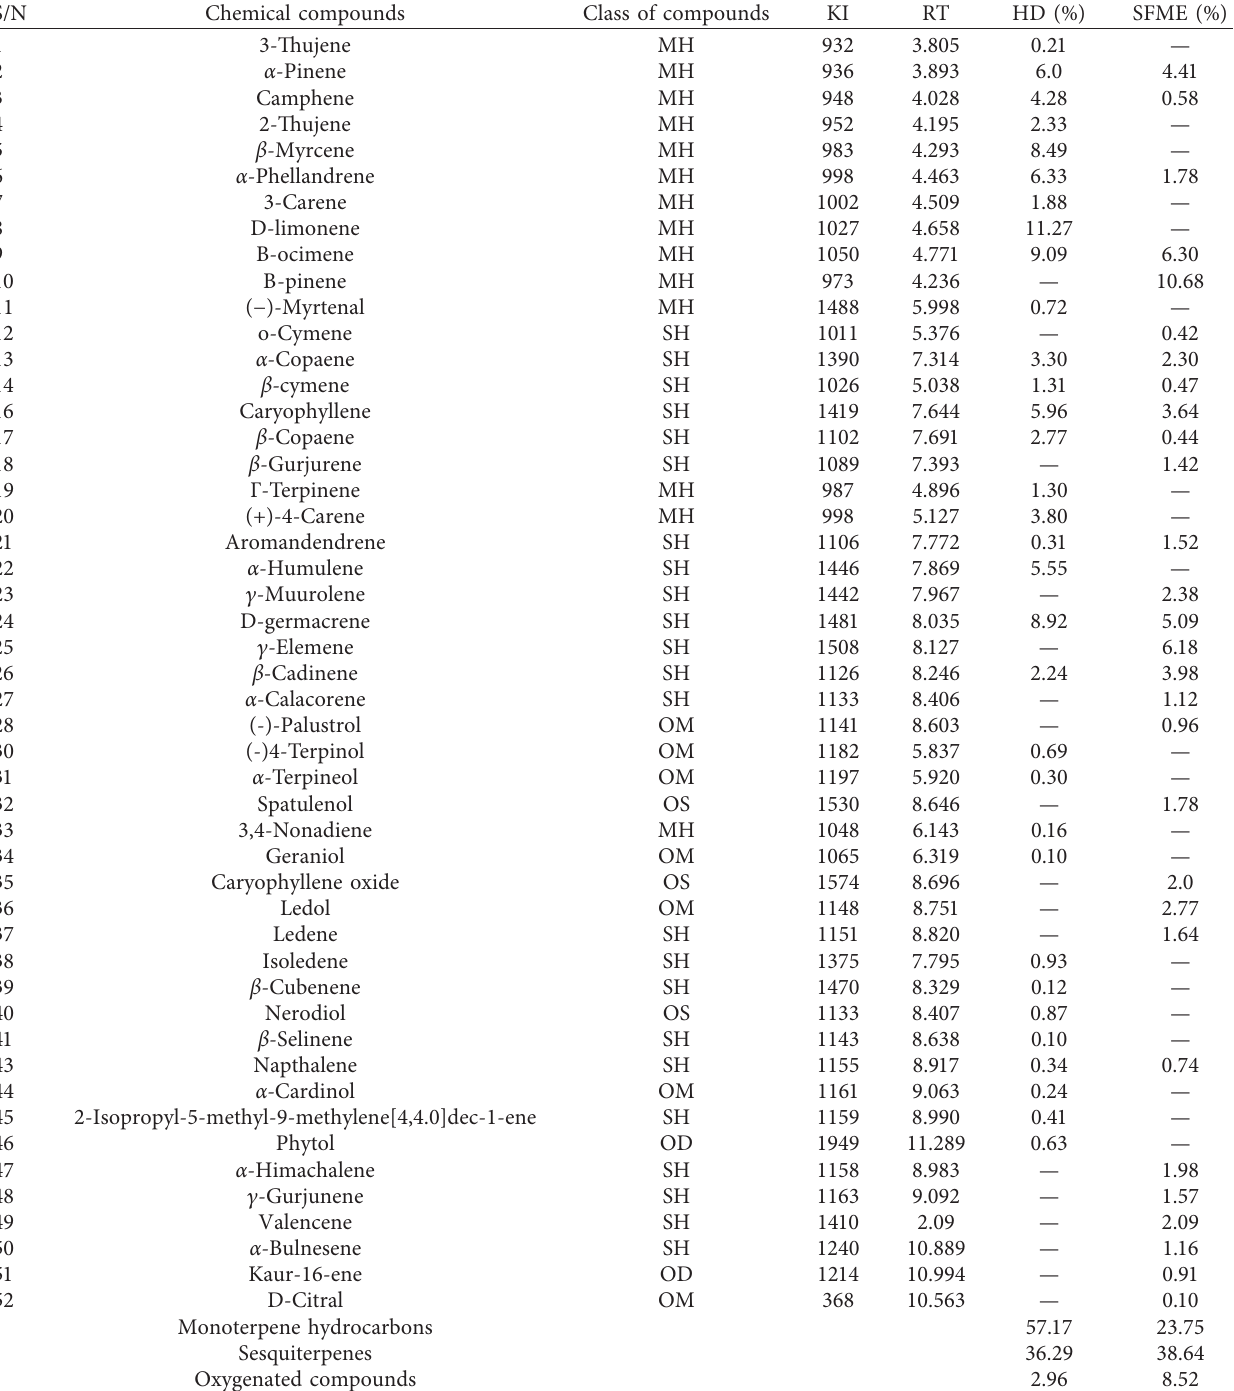
Table 1: Chemical constituents of essential oils obtained from H. arborescens leaves by hydrodistillation and solvent-free microwave extraction